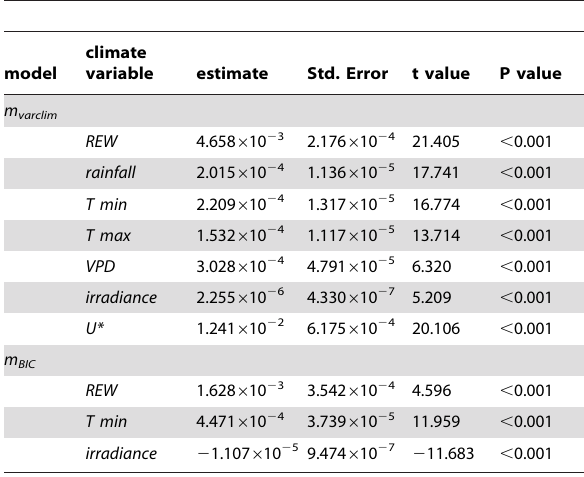
Table 4. Model parameters, standard errors and t values of the univariate ( m varclim ) and final multivariate ( m BIC ) analyses.